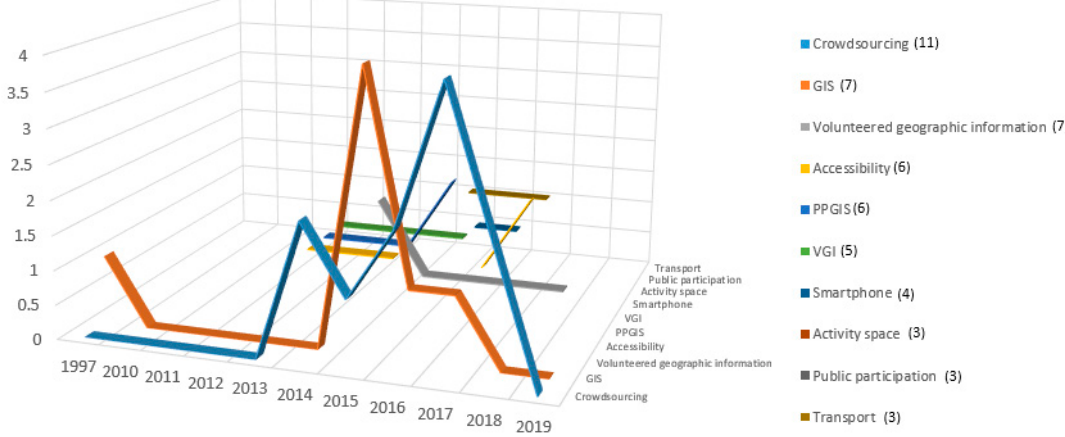
Figure 2. Keyword analysis of articles included in the review.